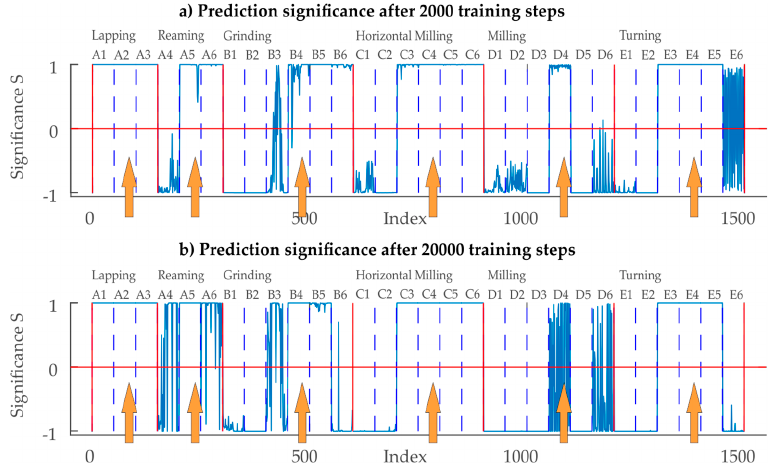
Figure 11. Prediction significance of the CNN trained with a reduced set of training data: Positive values display the difference to the 2nd largest significance of the SoftMax layer. Negative values display the difference from the largest SoftMax significance level to the level of the true class. Table 3. Classification performance of the CNN trained with the reduced training set with actual measurement data after 2000 training steps (upper row) and 20,000 steps (lower row). Lapping as Reaming as Grinding as HorizontalMillingas Milling as Turning